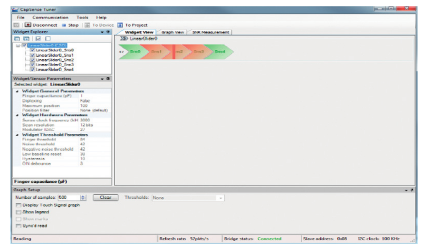
Figure 16: Tuner widget view.